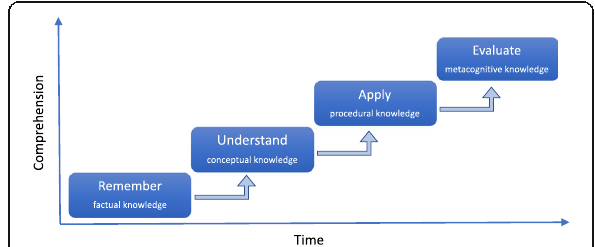
Fig. 1 Organizing the study process into four successive sessions of increasing level of comprehension, according to Bloom ’ s revised taxonomy in knowledge dimension